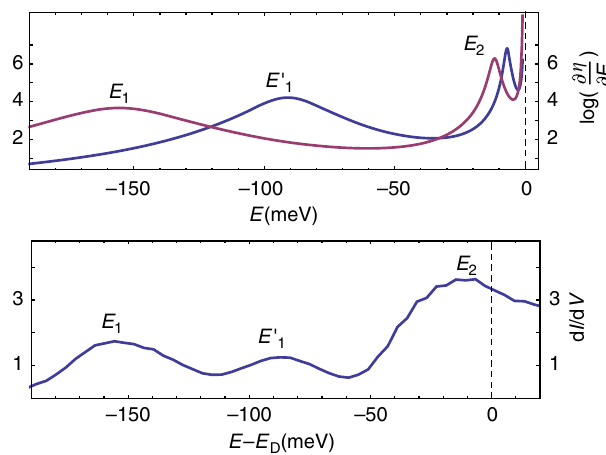
Fig. 4 Experimental and theoretical picture in the overcritical regime. Upper plot : Theoretical behavior of the low energy and scale-free part of the overcritical ( β = 1.33) quasi-bound states spectrum obtained from (6). The blue ( purple ) line corresponds to m = − 1 ( m = 0). Lower plot : Experimental values of the (STM) tunnelling conductance measured at the position of charged vacancies in graphene. The labelling E 1 , E 2 , E ′ explained in the